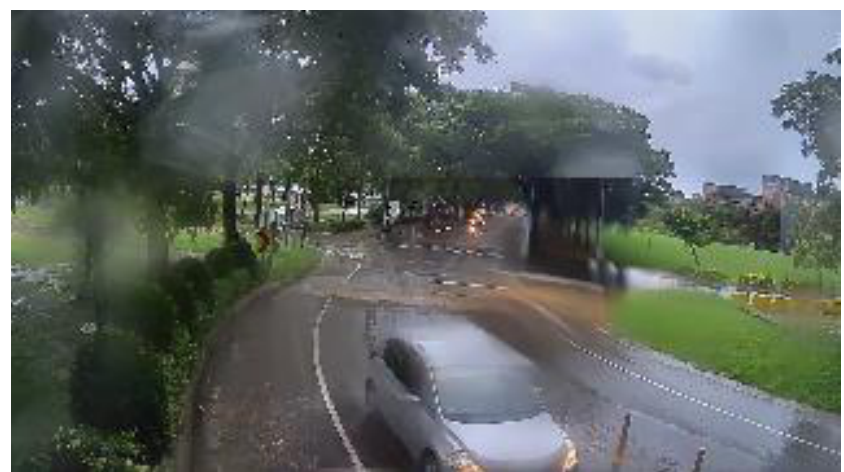
Figure 30. Rainy scene image frame detected by YOLOv3.